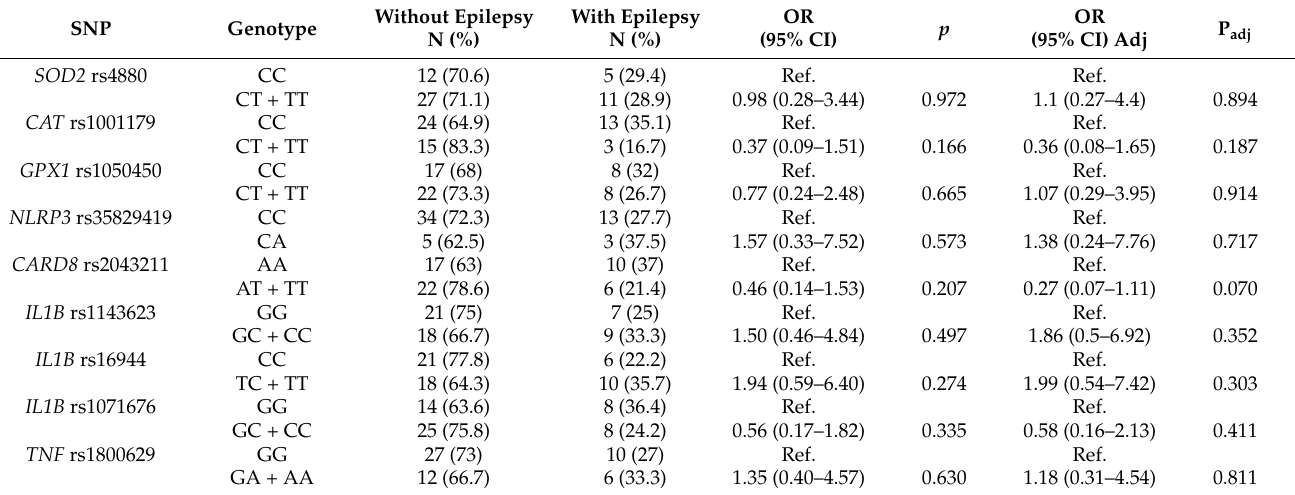
Table 4. The association of common polymorphisms with epilepsy.